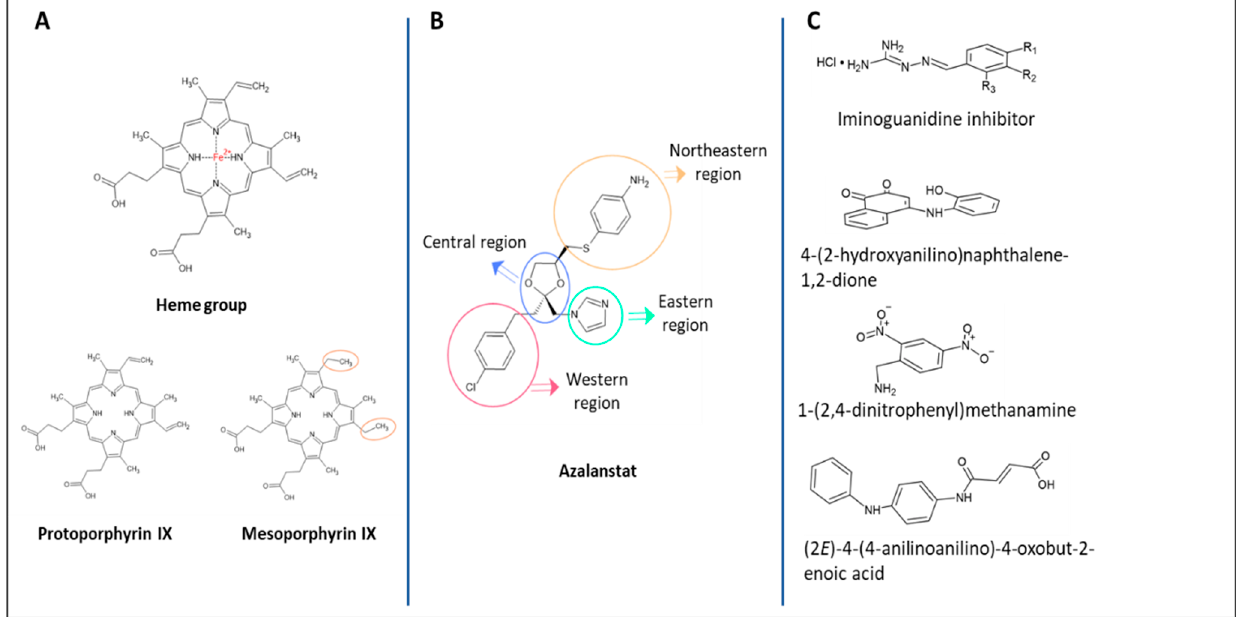
Figure 2. HO system inhibitors. ( A ) The first generation of HO competitive inhibitors are based on the protoporphyrin structure shared by the heme group. ( B ) Azalanstat structure, basis of the second generation of non-competitive HO inhibitors. Central and eastern regions originate the imidazole-dioxolane compounds. ( C ) Small molecules that inhibit bacterial heme oxygenase (HemO), differences in the heme-binding pocket between the pathogen and host allow these approaches to act as bacteria-specific antimicrobial drugs.